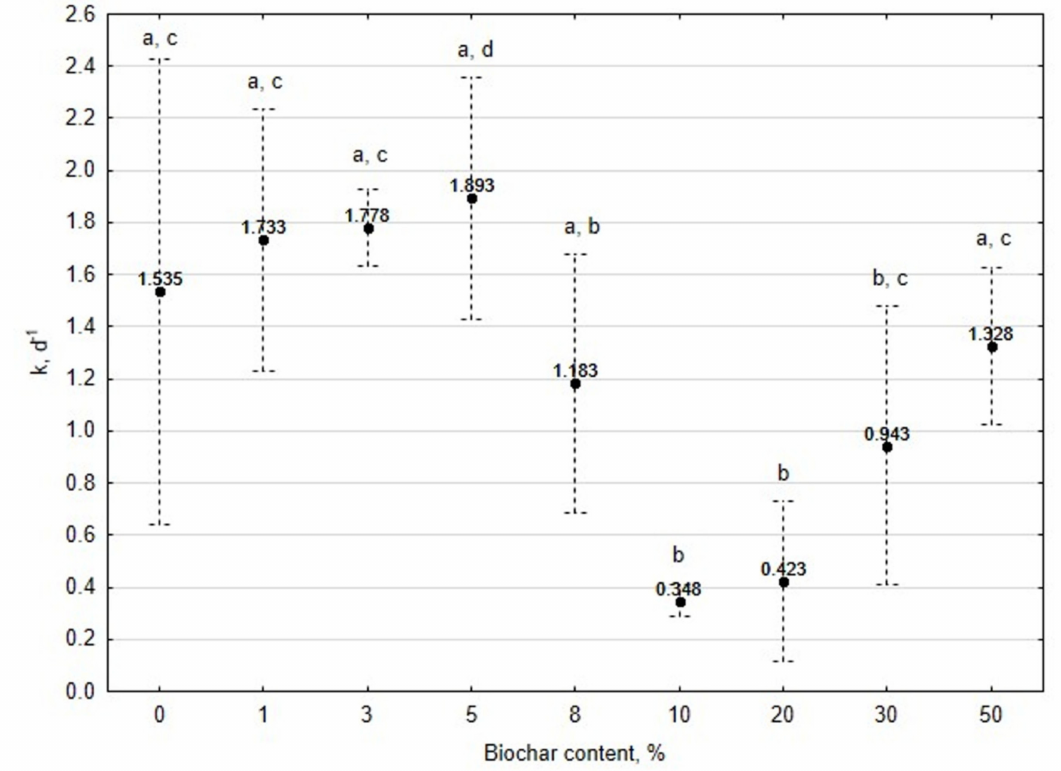
Figure 4. The influence of biochar (BC) mass content (%) addition to brewer’s spent grain (BSG) digestion on reaction rate constant ( k ), d − 1 . Letters show significant di ff erences ( p < 0.05) between mean